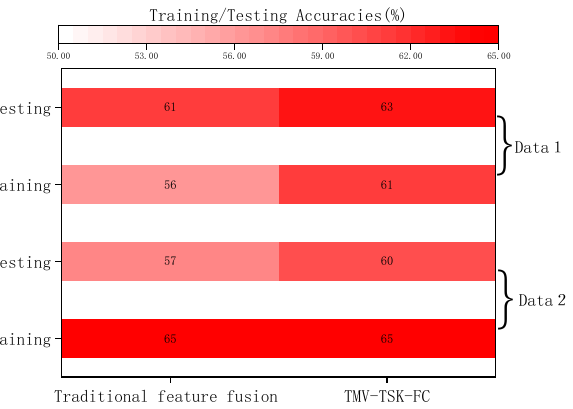
Figure 9. Comparison between TMV-TSK-FC and different decision coefficient matrix algorithms.